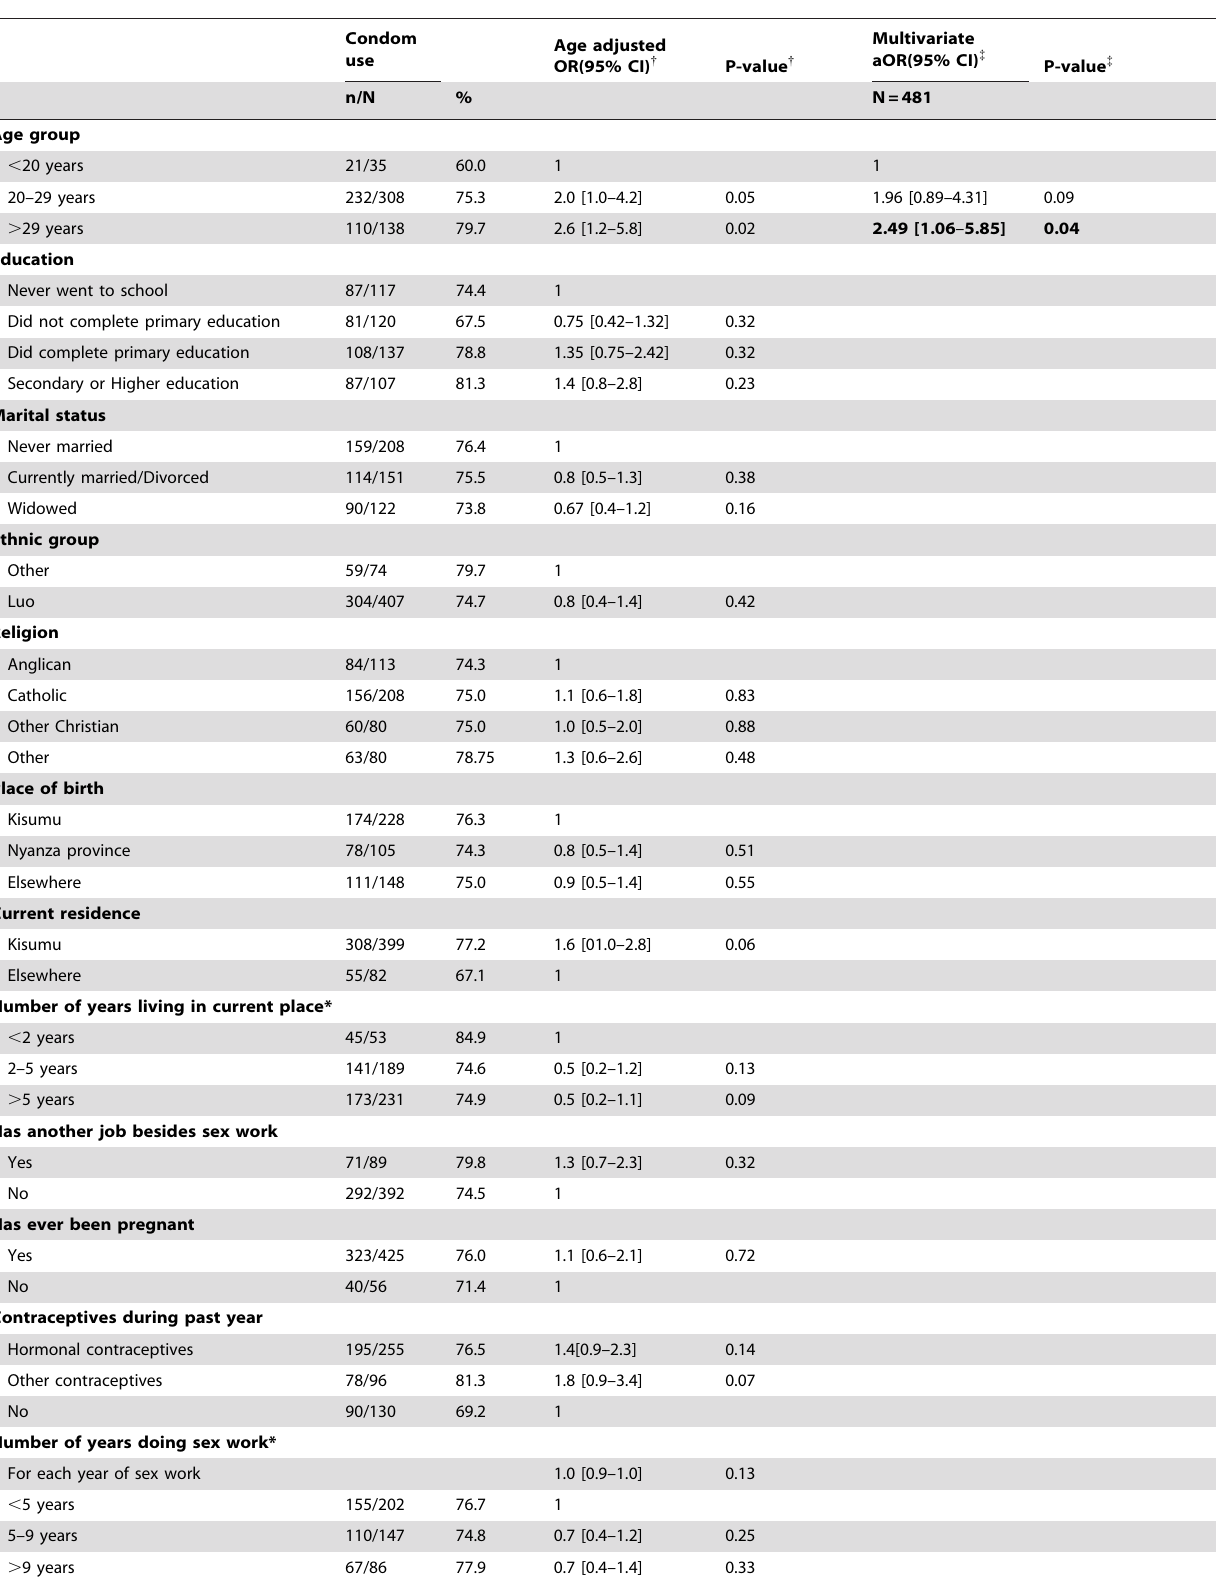
Table 4. Predictors of Condom use with last client among FSW (N =481) – Age-adjusted and multivariate